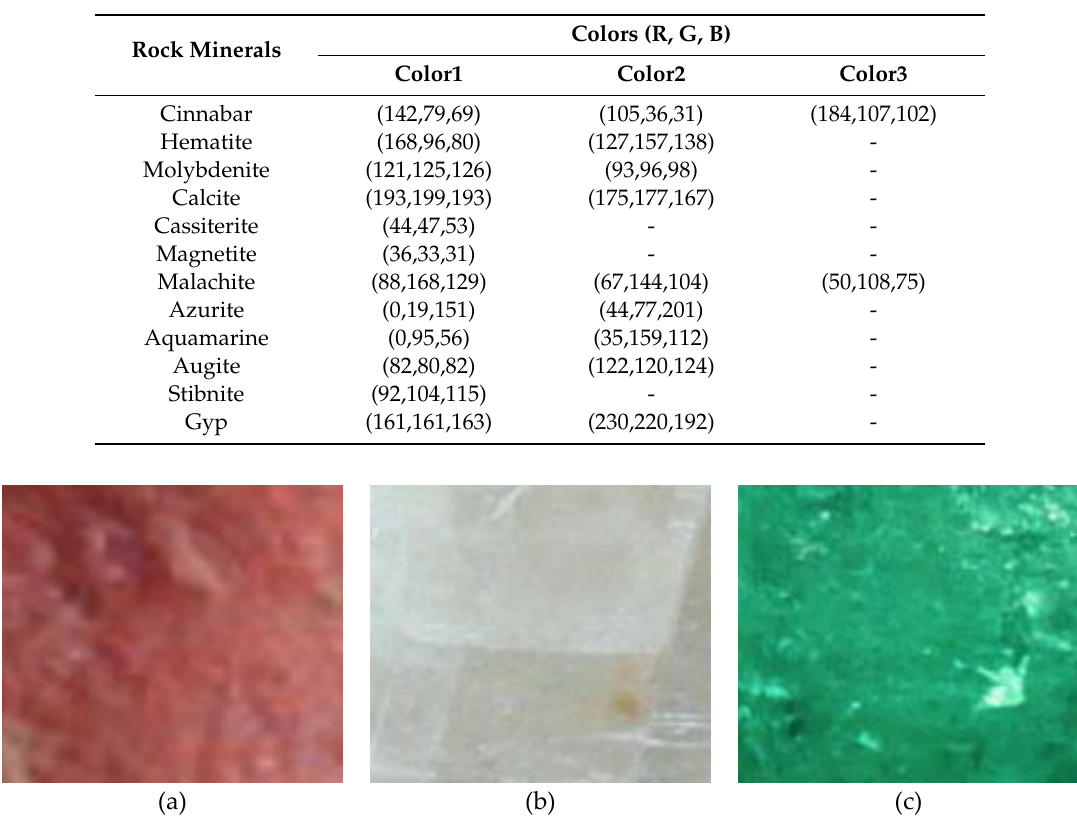
Figure 7. Training samples of color model. ( a ) Cinnabar; ( b ) calcite; ( c ) aquamarine. Table 3. Training results of color model.